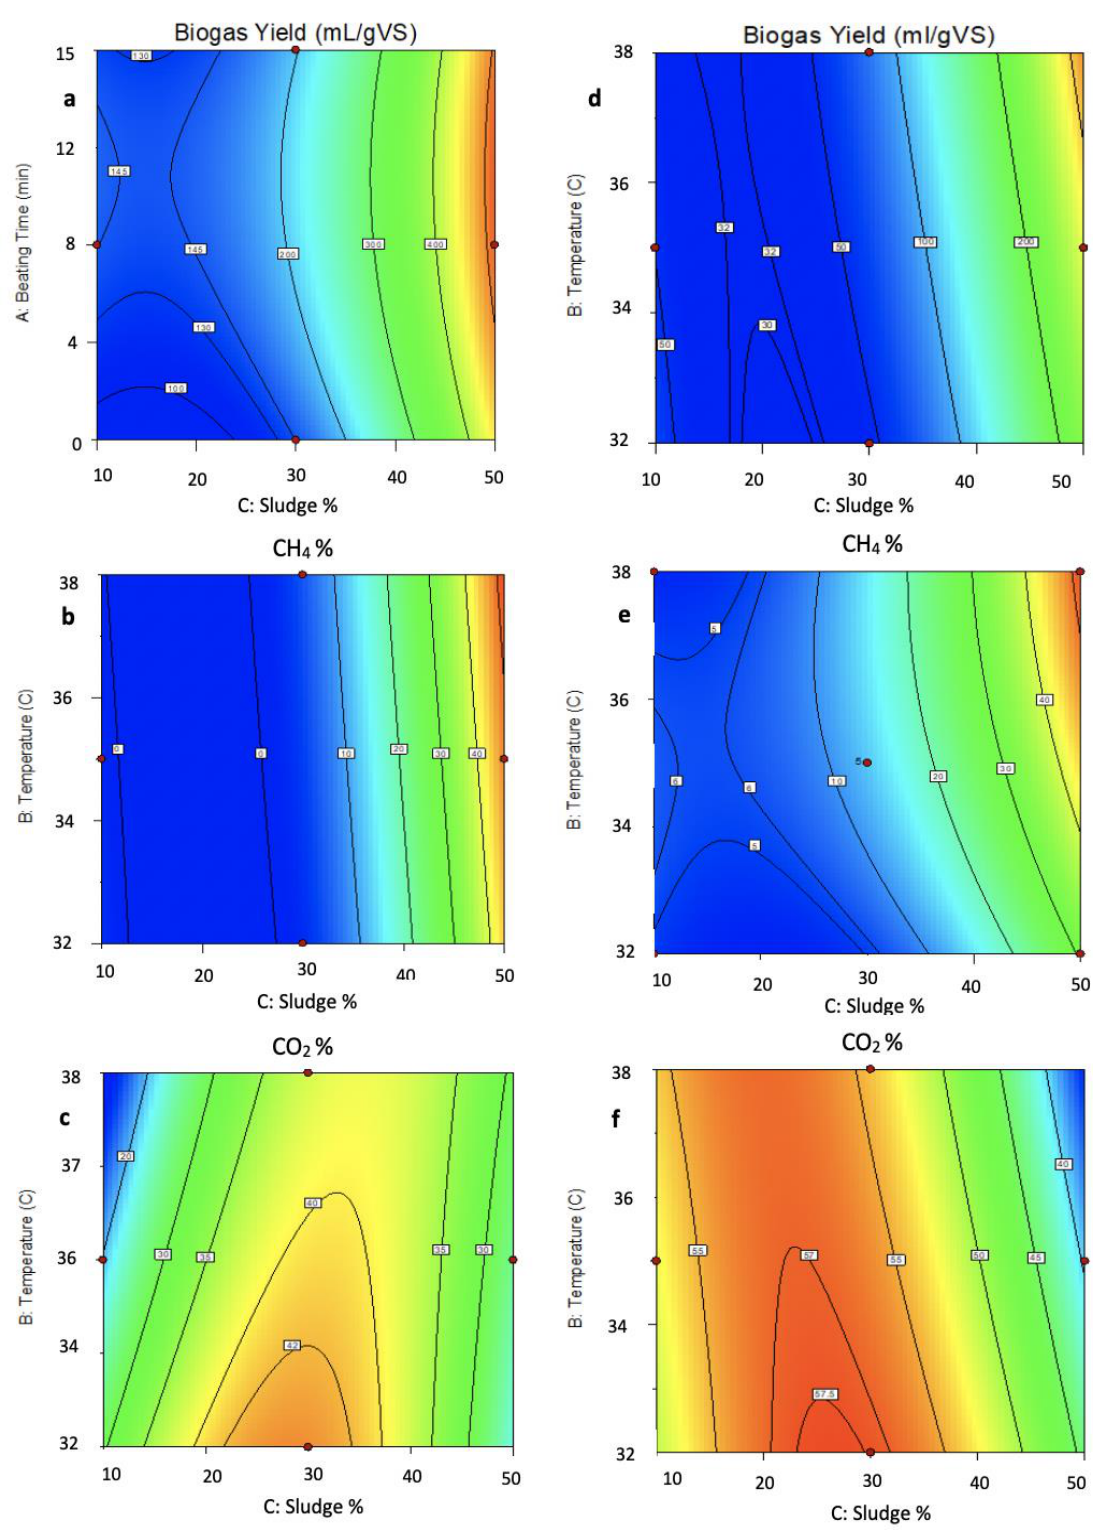
Figure 9. Contour graphs for AD of pot ale and spent grain pot ale mix on biogas yield ( a , d ), CH 4 % ( b , e ), and CO 2 % ( c , f ) respectively.